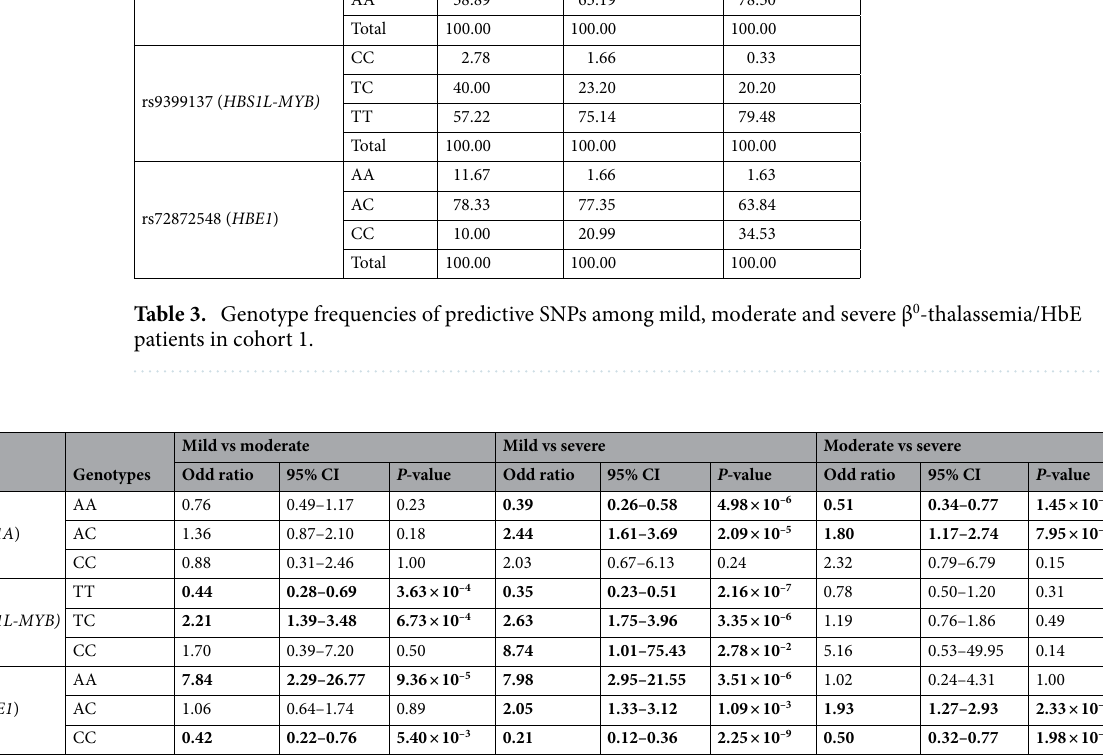
Table 4. The risk genotypes of the predictive SNP among mild, moderate and severe β 0 -thalassemia/HbE patients in cohort 1. Bold letter indicate P -value <